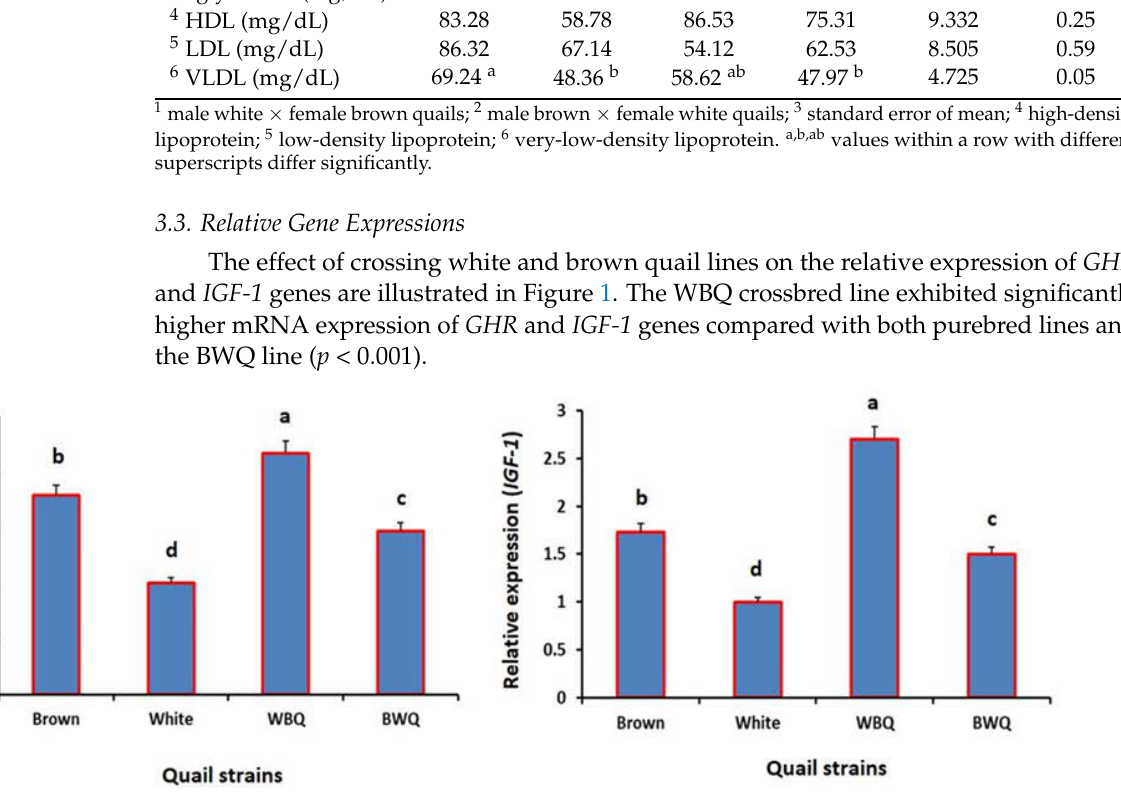
Figure 1. Effect of crossing white and brown quail lines on the relative expression of growth hormone receptor (GHR; p < 0.001) and insulin-like growth factor-1 (IGF-1; p < 0.001) genes. WBQ: male white × female brown quails; BWQ: male brown × female white quails; a,b,c,d values within a figure with different superscripts differ significantly.